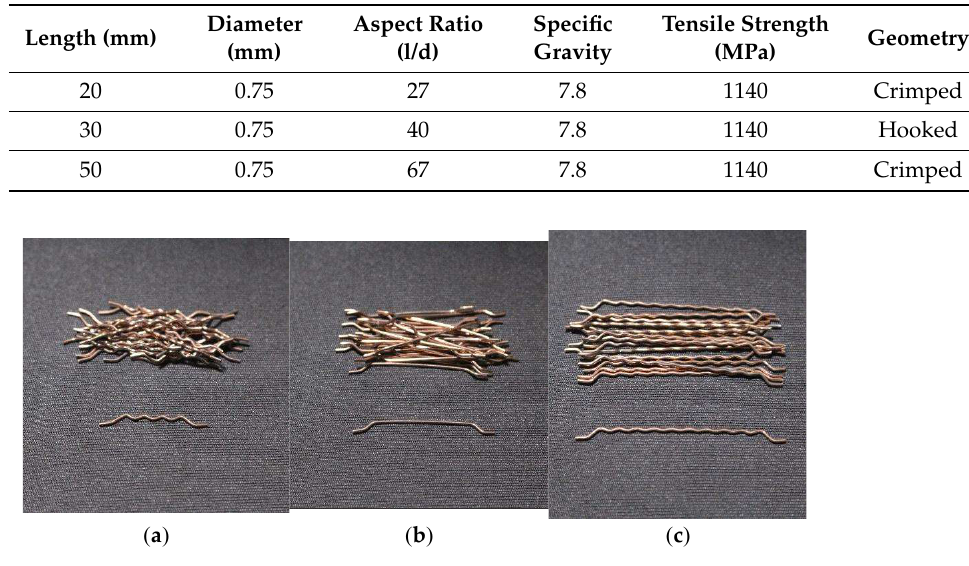
Figure 3. ( a ) Crimped hooked-end steel fiber [2 cm]; ( b ) Hooked-end steel fiber [3 cm]; ( c ) Crimped hooked-end steel fiber [5 cm].